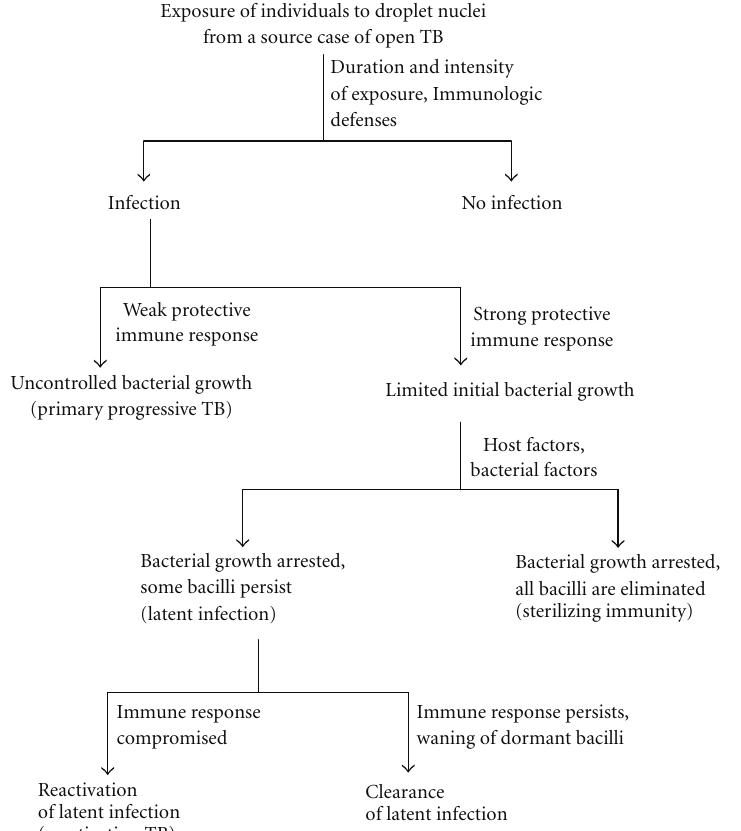
Figure 1: Progression of natural course of events and outcome in an immunocompetent individual following exposure to droplet nuclei containing M. tuberculosis expectorated by a source case of sputum smear-positive pulmonary (open)